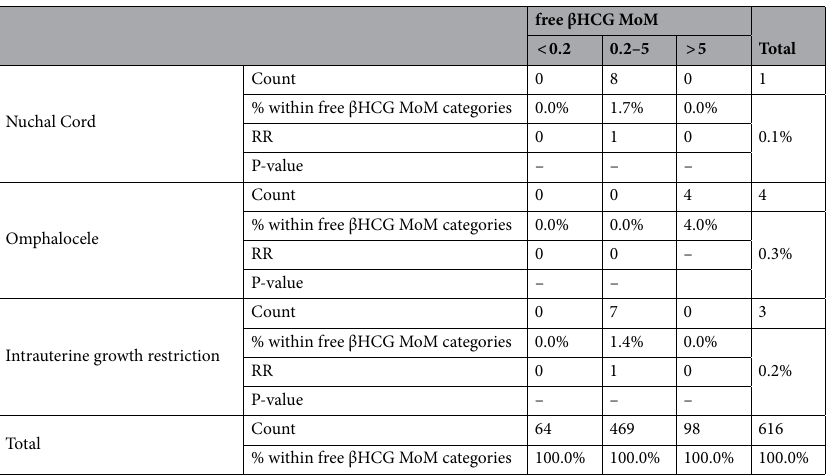
Table 3. Frequencies of other neonatal complications between different groups of pregnant women based on the levels of free βHCG MoM (RR, relative risk).